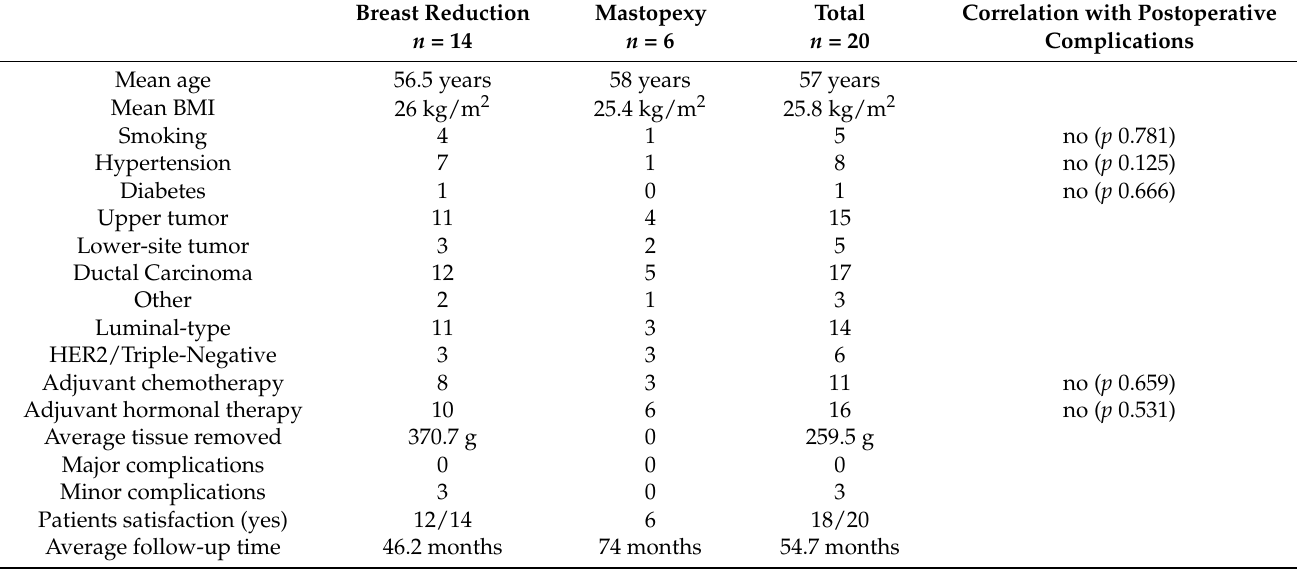
Table 1. Clinical and pathological